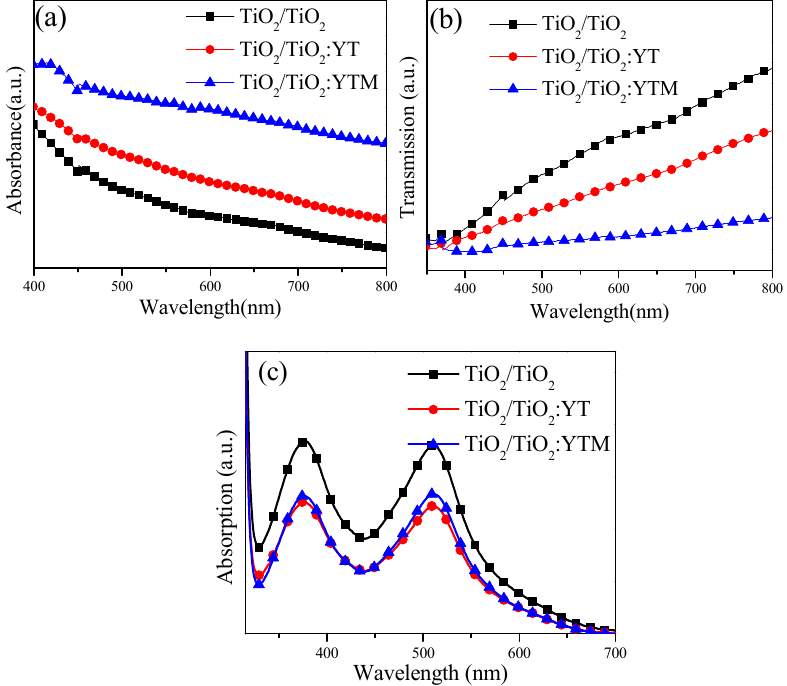
Figure 4. UV-vis spectra of TiO 2 /TiO 2 , TiO 2 /TiO 2 :YT and TiO 2 /TiO 2 :YTM photoanodes: ( a ) Absorp- tivity; ( b ) Transmittance; ( c ) UV-vis spectra of N719 dye desorbed from photoanodes. The bi-function TiO 2 /TiO 2 :Yb 3+ /Tm 3+ /Mn 2+ double-layered photoanode is used to im- prove the light absorption and performance of DSSCs, and a schematic design of the dou- ble-layered DSSC structure is shown in Figure 5a. The photocurrent density–photovoltage ( J-V ) plots of TiO 2 -DSSC, TiO 2 :YT-DSSC and TiO 2 :YTM-DSSC are shown in Figure 5b, and the corresponding photovoltaic parameters including open-circuit voltage ( V oc ), short-cir- cuit photocurrent density ( J sc ), fill factor (FF) and power conversion efficiency (PCE) are listed in Table 1. TiO 2 -DSSC, TiO 2 :YT-DSSC and TiO 2 :YTM-DSSC display J sc of 0.63, 0.66 and 0.67 mA cm 2 , V oc of 14.84, 15.37 and 15.68 V, FF of 0.73, 0.70 and 0.71, and PCE of 6.84%, 7.12% and 7.41%, respectively. The enhanced PCE of 7.41% in TiO 2 :YTM-DSSC is due to the broadened solar spectral response range and the increased light-scattering ability, as proved by effective UC of TiO 2 :YTM nanospheres (Figure 3a). Moreover, the N719 dye molecules could absorb more visible light with the help of TiO 2 :YTM nanospheres, yield-